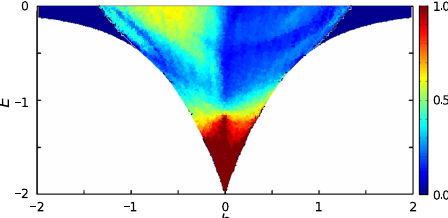
Fig. 1. Lindblad’s diagram for the Schuster-Plummer potential model ( a = 0 : 5, (cid:13) = 1 : 28) with the heat map of escaped stars (see scale at right: blue { all stars with cor- responding initial conditions left the cluster, red { all stars remained in the cluster). x - axis displays momentum h 2 [ (cid:0) 2 : 0; 2 : 0], and y -axis displays energy E 2 [ (cid:0) 2 : 0; 0 : 0].